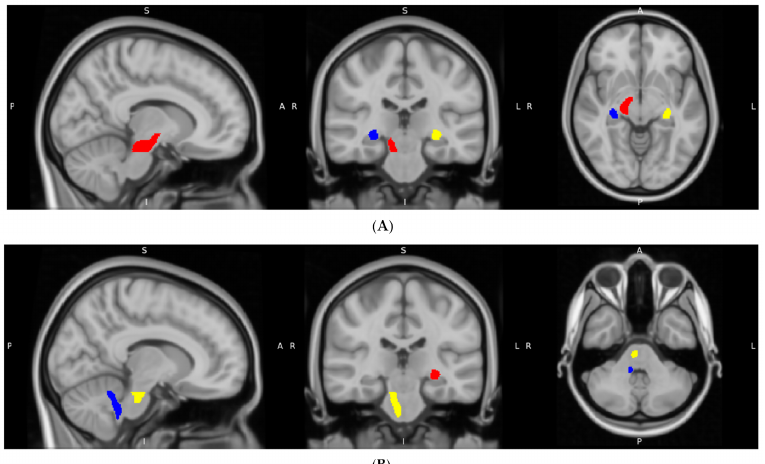
Figure 3. WM regions with significant differences in FA and MD values. ( A ) regions with significant differences in FA (red: right CP; yellow: left FX/ST; blue: right FX/ST) ( B ) regions with significant differences in MD (red: left FX/ST; yellow: right CST; blue: right